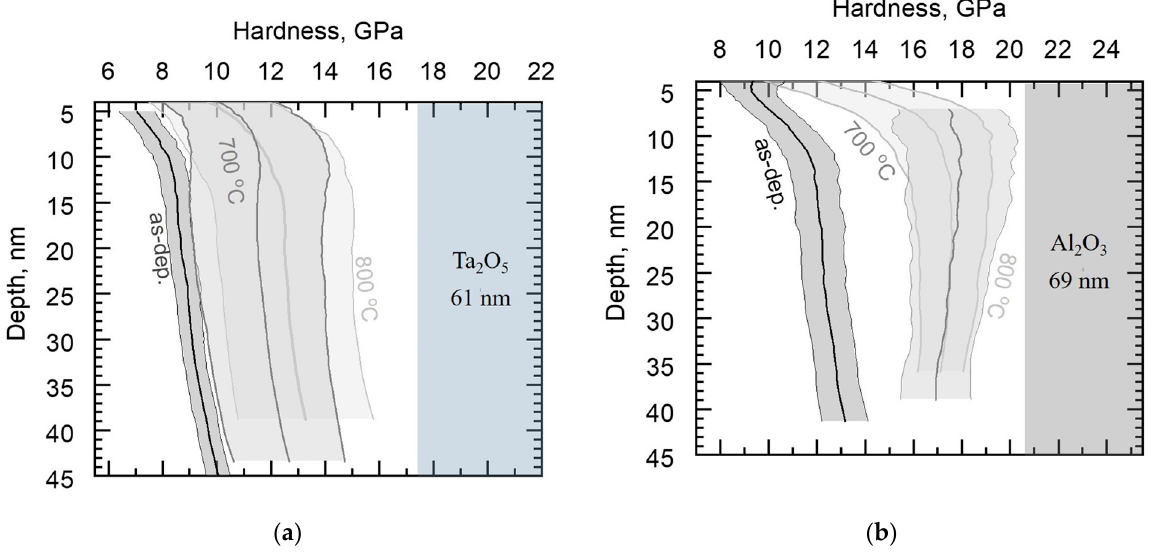
Figure 10. Average hardness along the fi lm depth, with standard deviation of the layered structure of the fi lm schematized on the right side of the panel: ( a ) as-deposited and annealed Ta 2 O 5 /Si; ( b ) as-deposited and annealed Al 2 O 3 /Si.